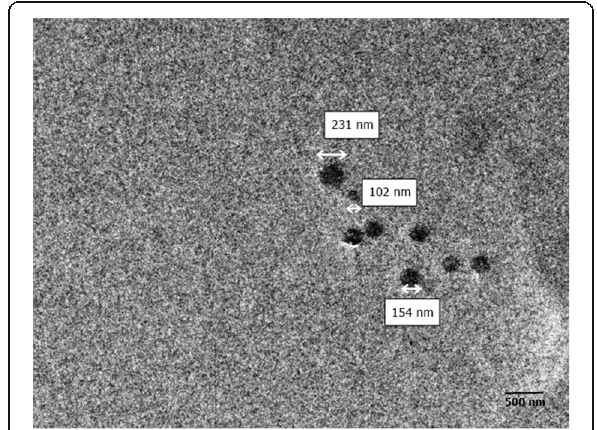
Fig. 8 TEM image of the optimized Eudragit nanoparticles